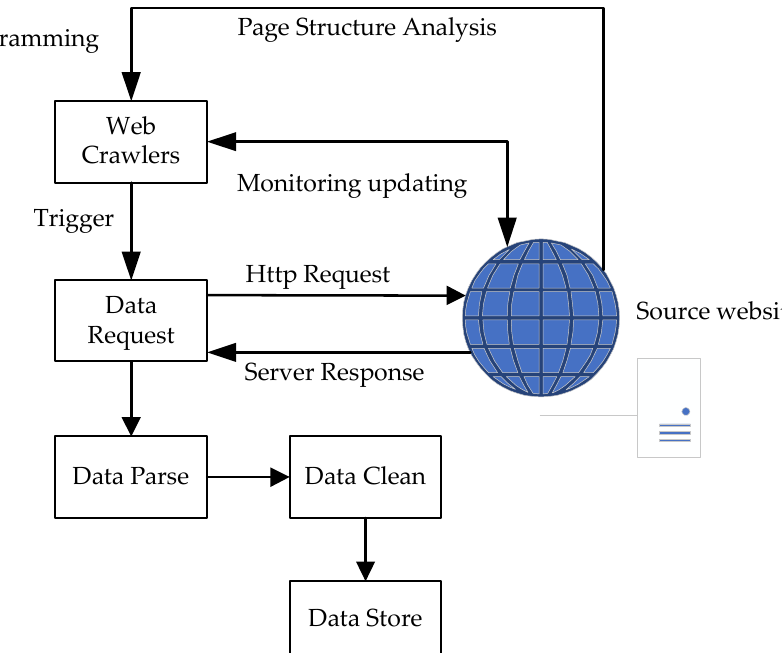
Figure 2. Process of data collecting by web crawler used in the system.